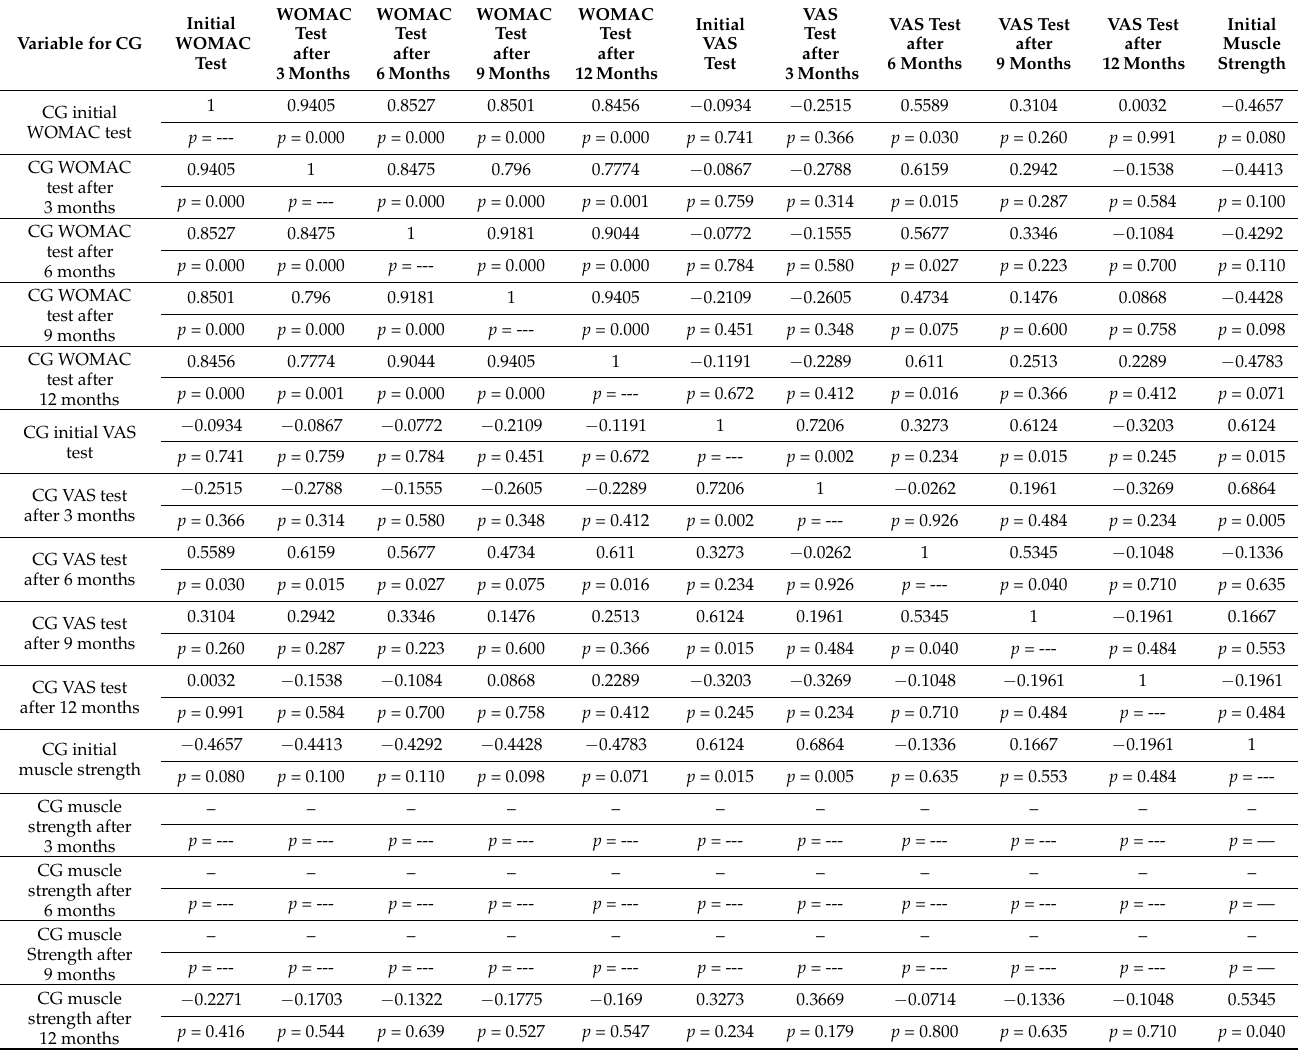
Table 5. Correlations between CG parameters of the